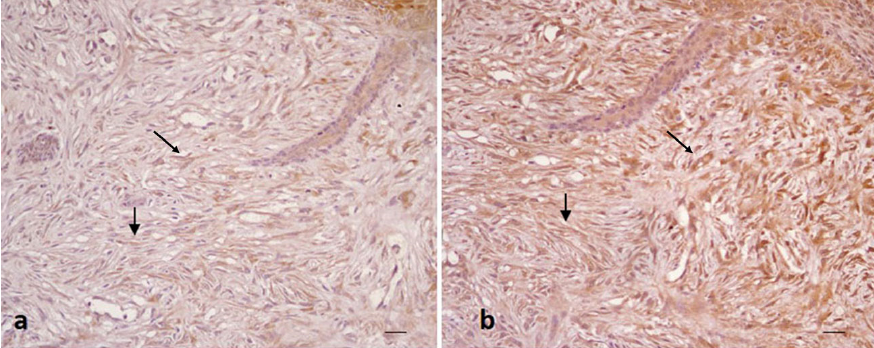
Figure 2. Equine sarcoid. Immunohistochemical staining. Neoplastic fibroblasts with moderate ( a ) and strong ( b ) positivity for LC3 ( a ) and P62 ( b ) (20X scale bar: 100 μ m).